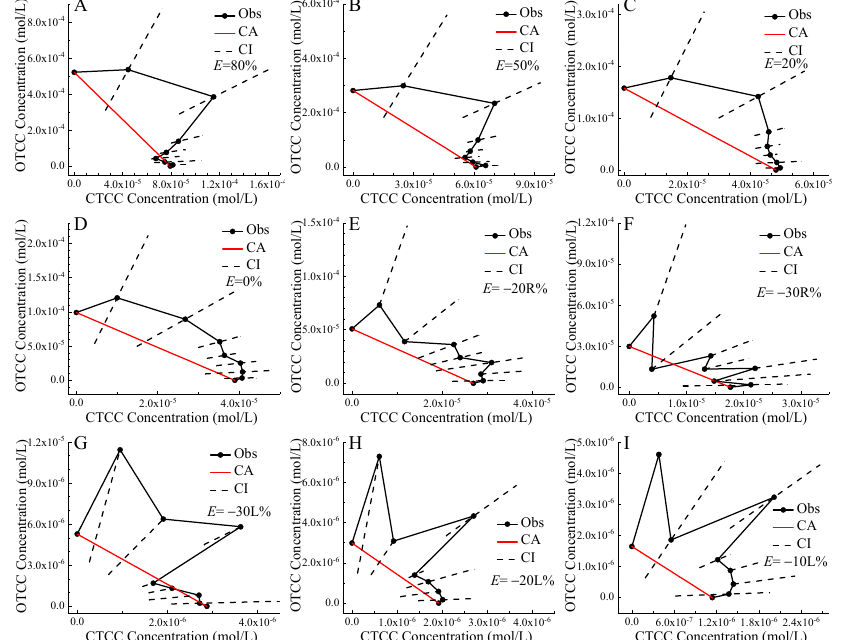
Figure 3. Isoboles of chlortetracycline hydrochloride (CTCC) and oxytetracycline hydrochloride (OTCC) to Allivibrio fischeri at 80% ( A ), 50% ( B ), 20% ( C ), 0% ( D ), − 20R% ( E ), − 30R% ( F ), − 30L% ( G ), − 20L% ( H ), and − 10L% ( I ) effect levels. Note: Black point: observed equivalent point; Black solid line: observed isobole; Black dashed line: confidence interval; Red line: CA isobole; L and R refer to the left and right of the lowest point of the J-CRC respectively; Except for the two boundary points on the black solid line, the remaining seven points in line order from left to right correspond to CTCC:OTCC molar